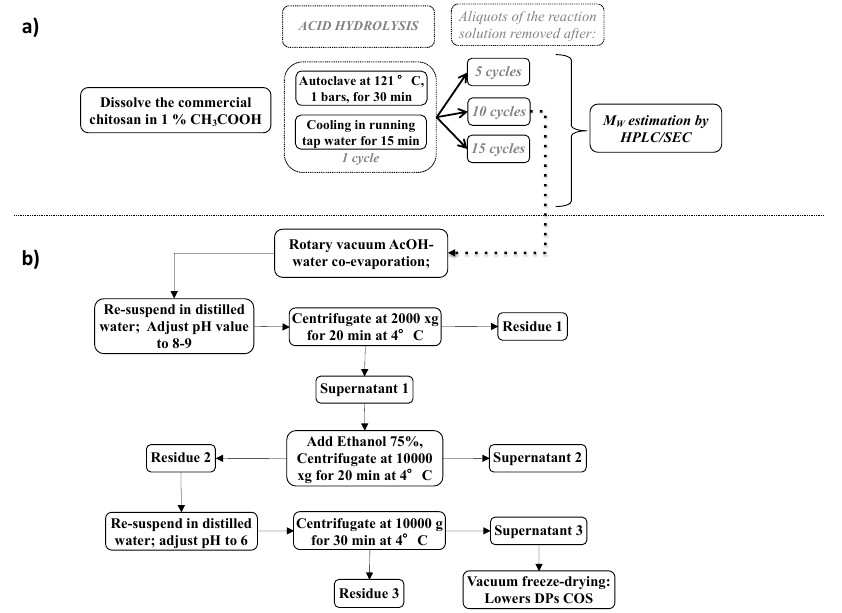
Figure 1. Schematic diagram of fungal chitosan acid hydrolysis ( a ) and chitosan oligomer produc- tion ( b ).